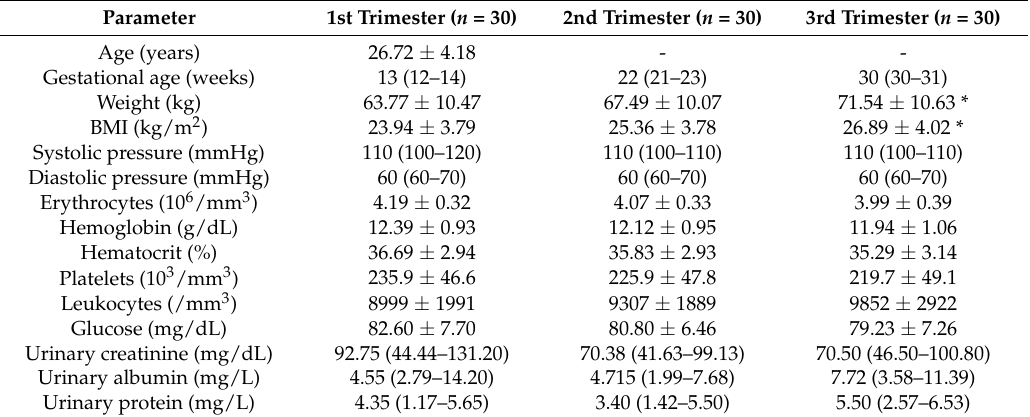
Table 1. Clinical and demographic characteristics in pregnant women in the three gestational trimesters.